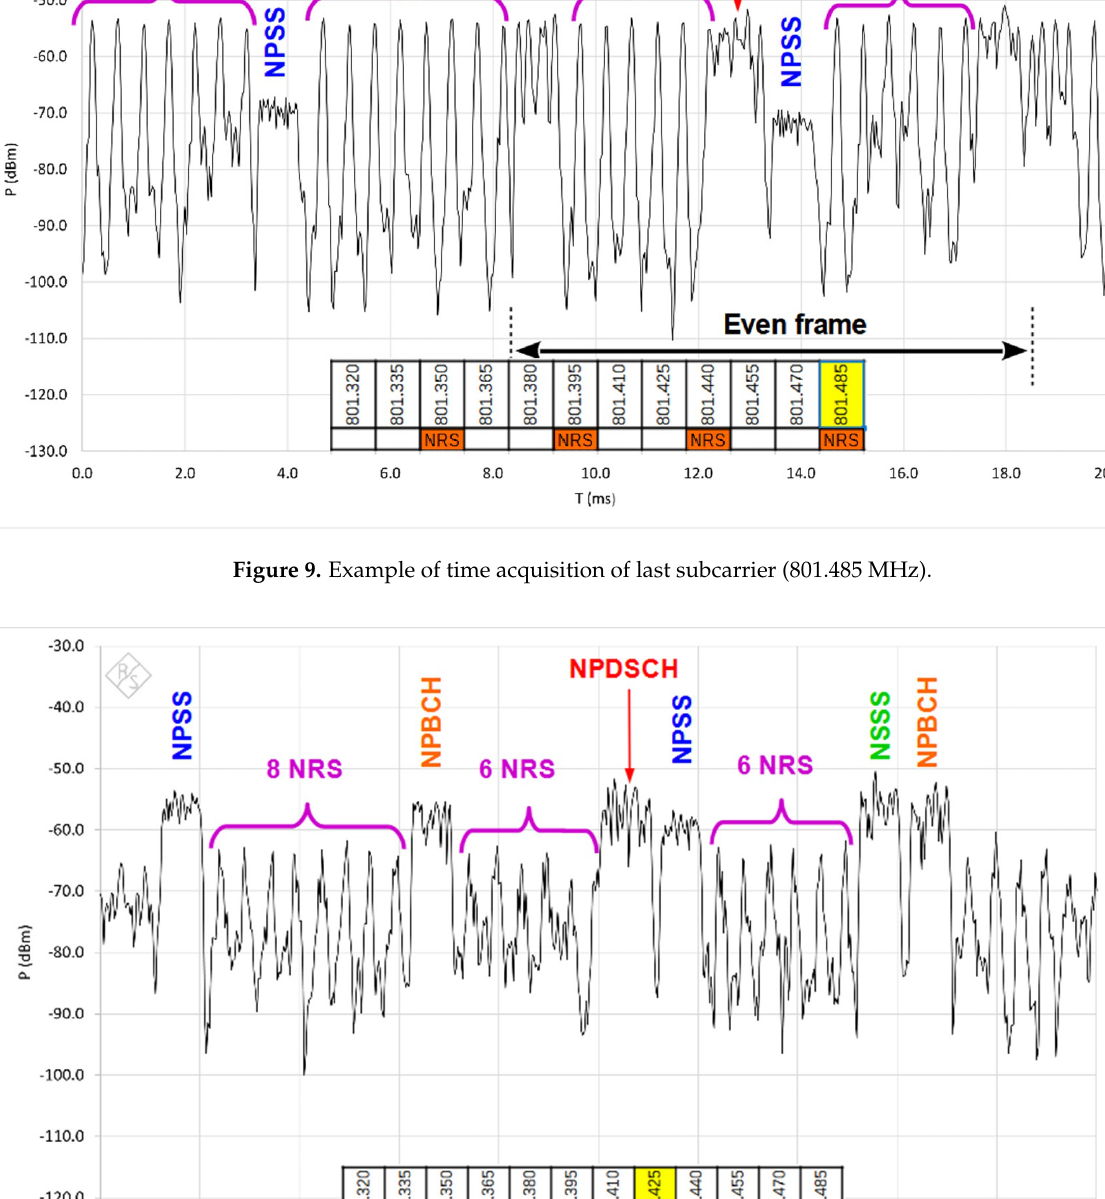
Figure 10. Example of acquisition of a subcarrier not transmitting NRS (801.425 MHz).